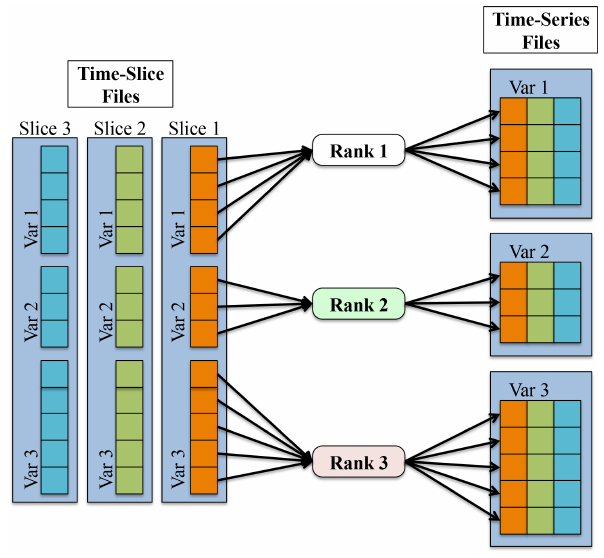
Figure 2. This figure shows the process of converting the data from a time-slice format to a time-series format in parallel within the PyReshaper. Each MPI rank is responsible for taking a particular variable from each time-slice file and writing it to the time-series file.